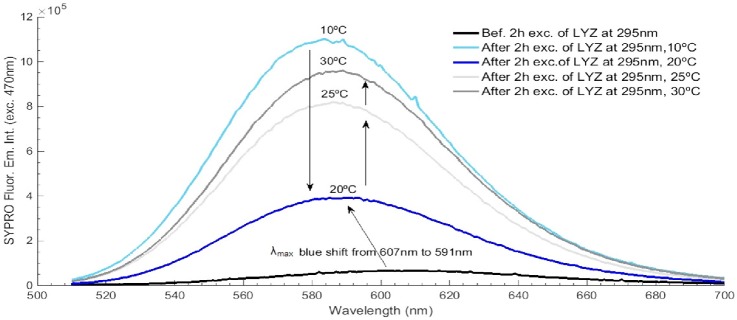
SYPRO® Orange emission intensity spectra before and after LYZ 295 nm excitation at different temperatures (10°C, 20°C, 25°C and 30°C).SYPRO® fluorescence excitation wavelength was fixed at 470 nm and acquired before and after the four open/close cycles. Excitation slit size was set at 0.5 mm (1.0 μW).